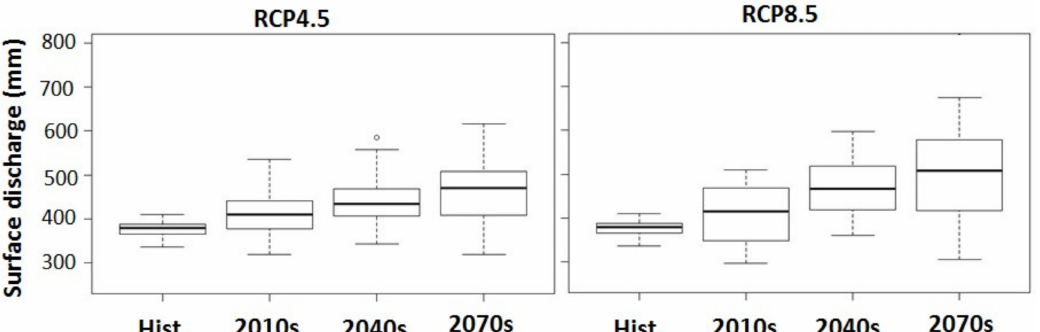
Figure 8. Percentage (%) change of surface discharge during the cropping period (June-September) in the Jeonju metrological station area for the 2010s (2nd column), 2040s (3rd column), 2070s (4rd column) considering RCP4.5 ( left side ) and (2) RCP 8.5 ( right side ) scenarios relative to the historical period (1st column) considered as baseline